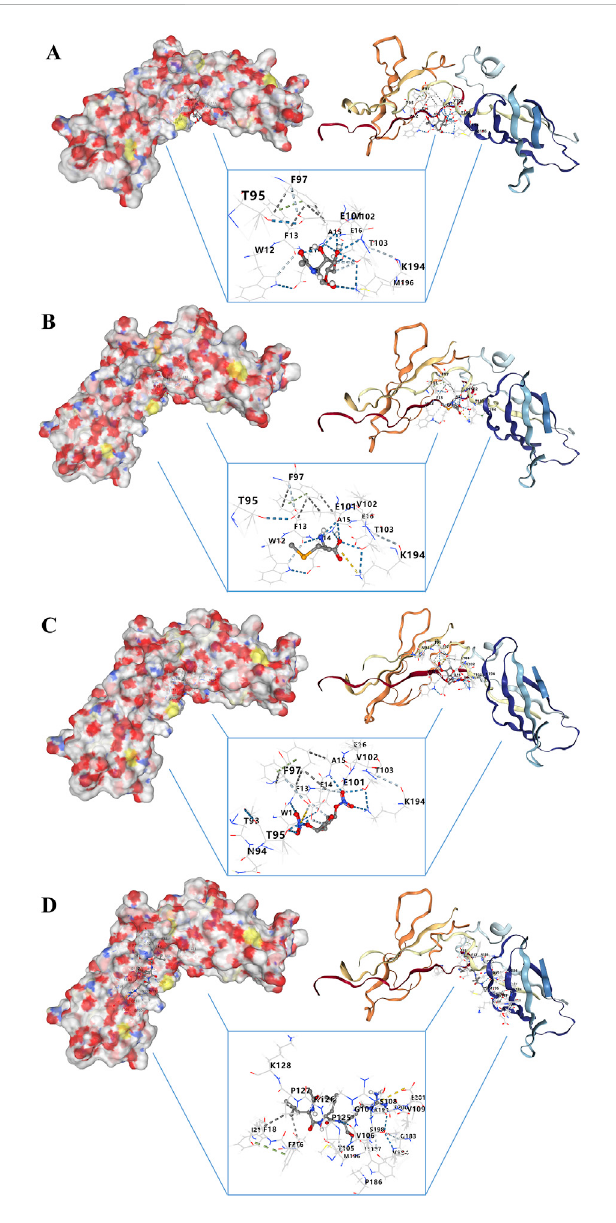
FIGURE 11 Molecular dockinganalysis ofdrug – geneinteraction. (A) Molecular docking between IL10RA and chitin. (B) Molecular docking between IL10RA and selenomethioni. (C) Molecular docking between IL10RA and isosorbide din. (D) Molecular docking between IL10RA and